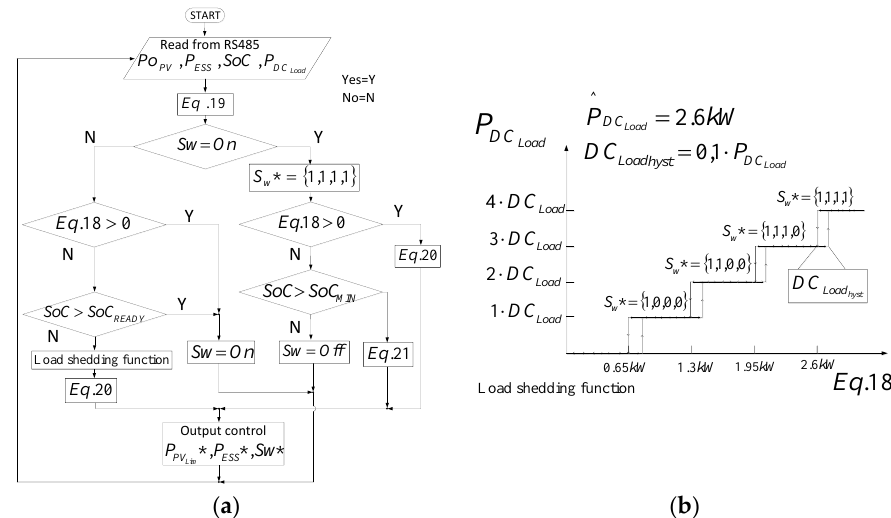
Figure 7. MGCC: ( a ) Power management algorithm of the DC microgrid; ( b ) Load shedding functionality.